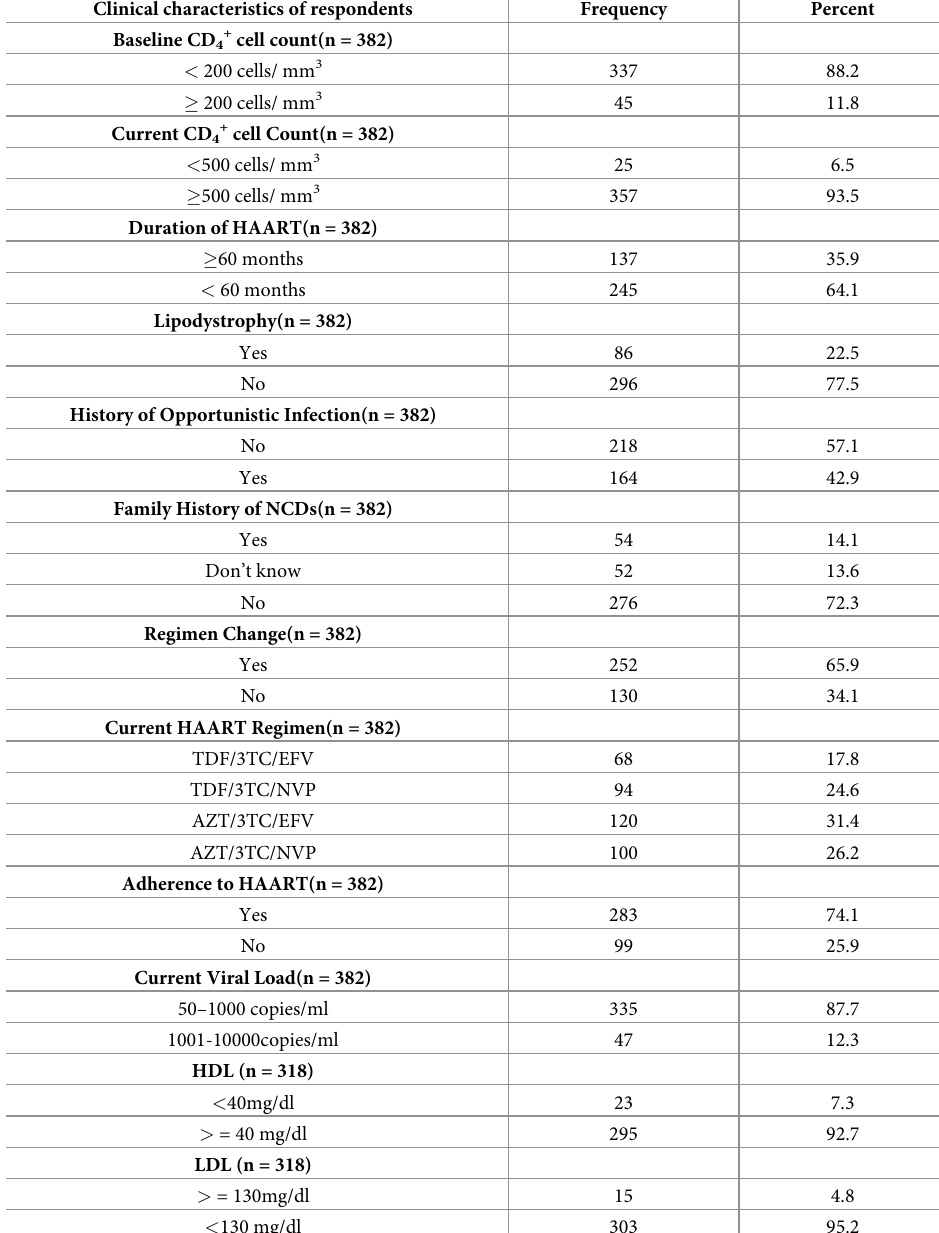
Table 2. Clinical profiles of clients on HAART at NEMMRH, Southern Ethiopia, January 20-March 20, 2020. Clinical characteristics of